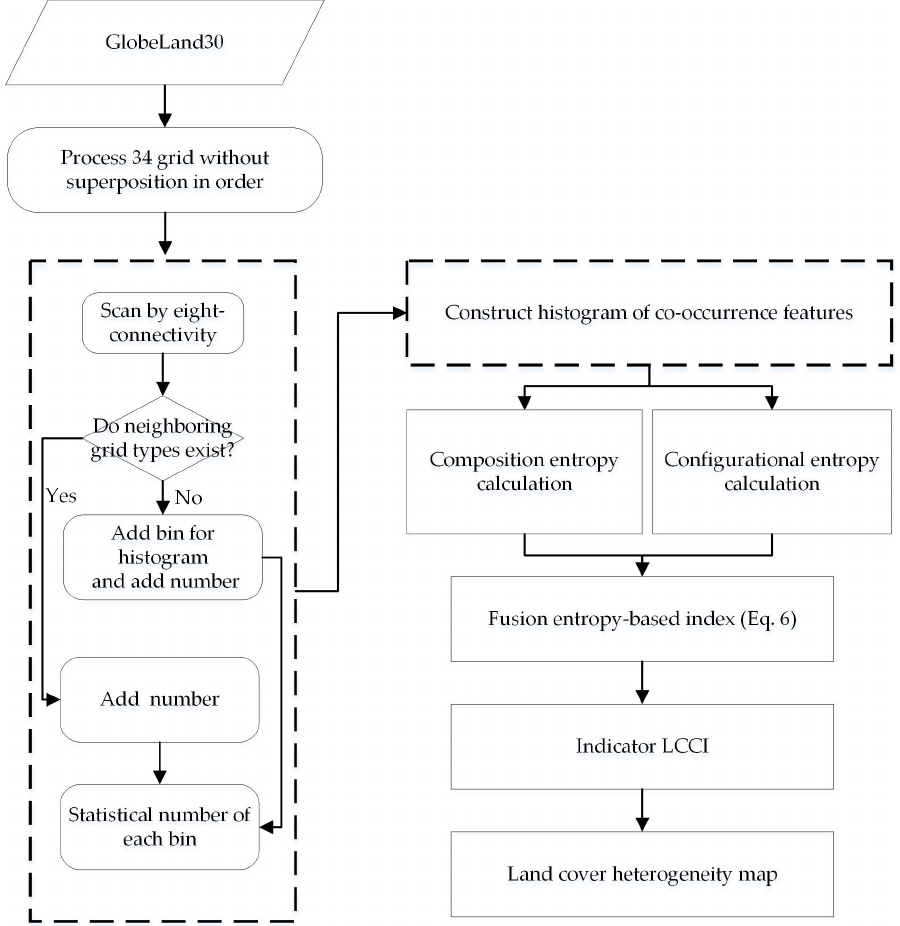
Figure 3. Flowchart of the heterogeneity information extraction